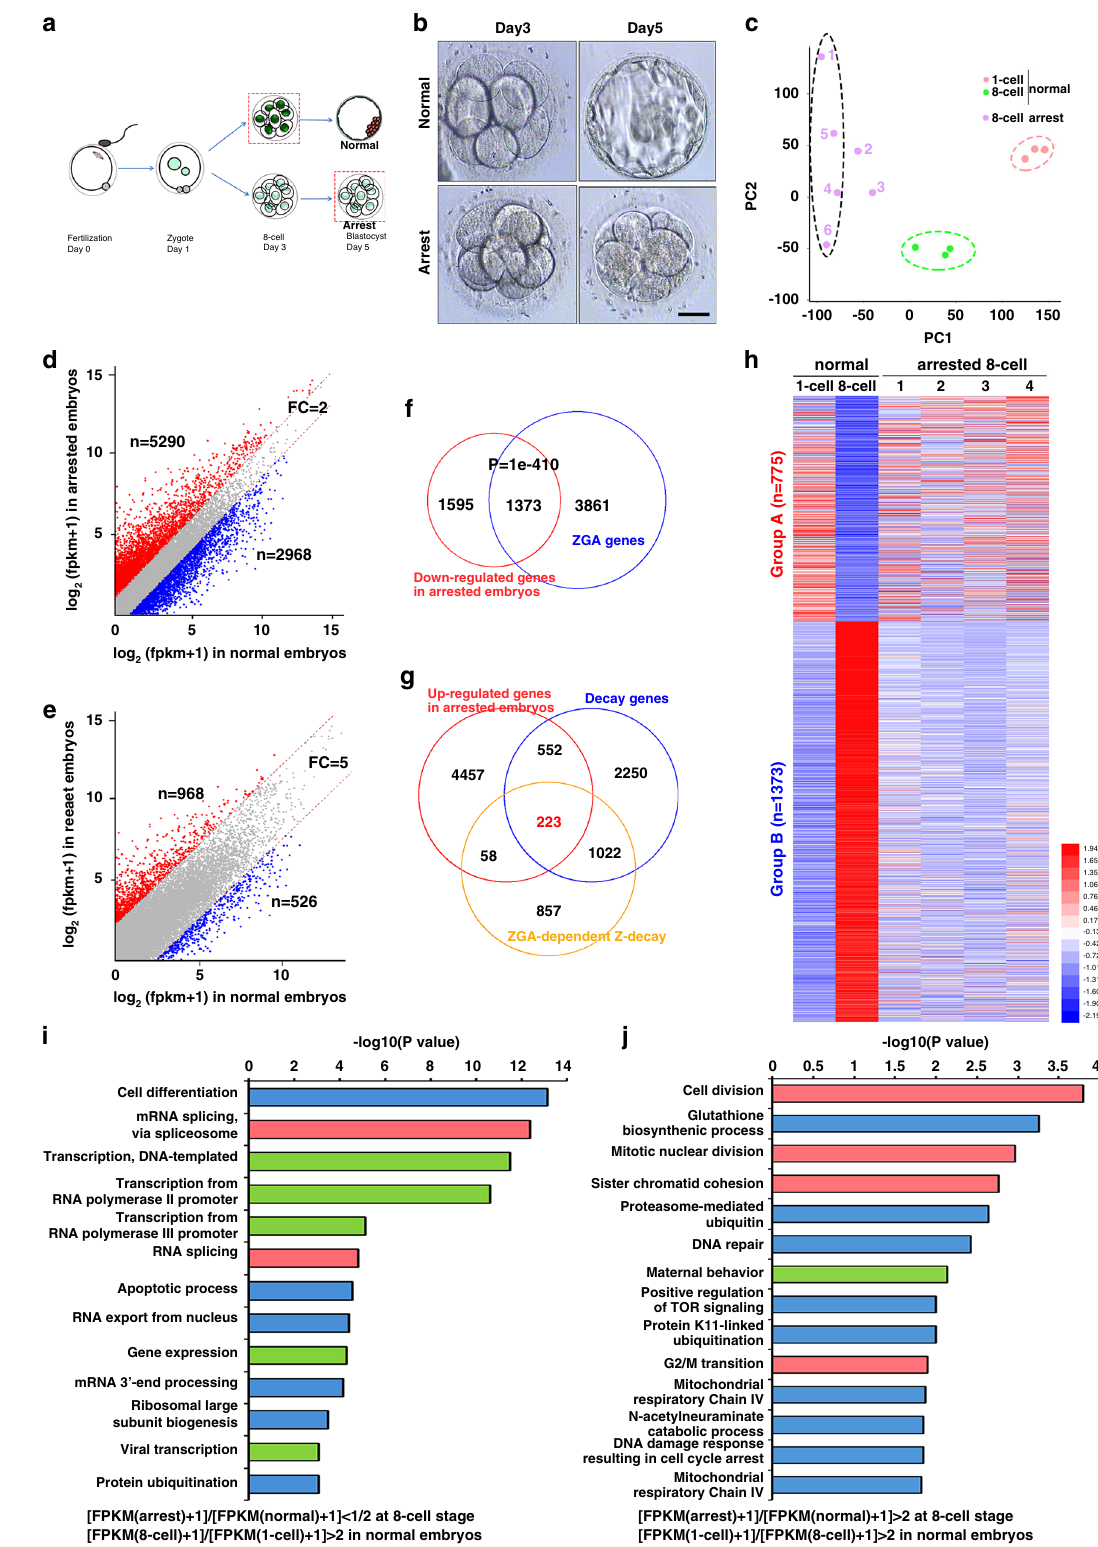
IVN-acetylneuraminate catabolic process DNA damage response resulting in cell cycle